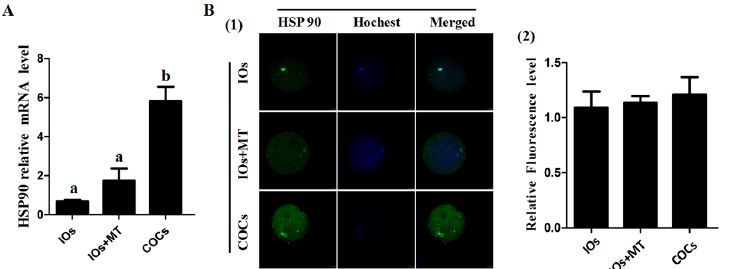
Figure 4. Effects of melatonin on expression of HSP90 in bovine oocytes. ( A ) Effects of melatonin on the levels of HSP90 mRNA; ( B ) the effects of melatonin on the HSP90 protein levels. B(1) The representatives of immunofluorescent inmages of HSP90 protein in MII bovine oocytes, scale bar = 25 μ m; and B(2) The statistical analysis of the data from B1, HSP90 fluorescence intensity was analyzed using in MII-stage oocytes (mean ± SEM of 42 oocytes). a,b Values of different superscripts indicate significant difference ( p < 0.05).